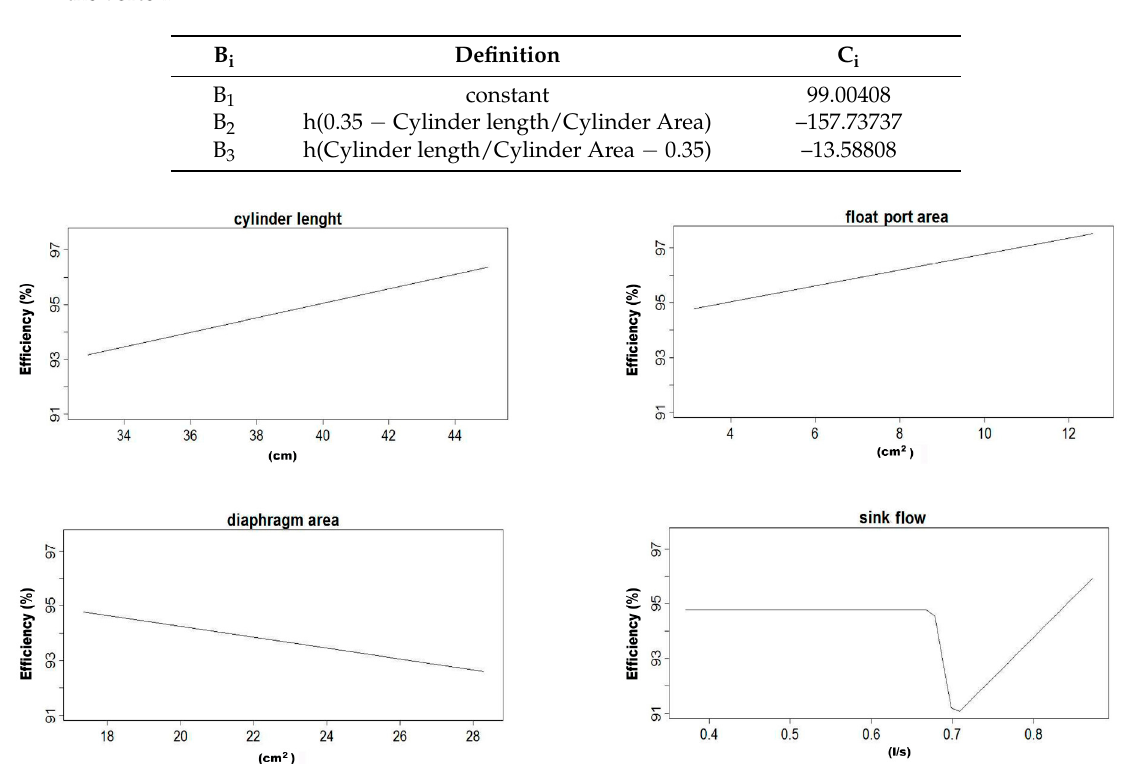
Figure 2. Graphical representation of the basis functions of MARS model number one and their coefficients for feed with media.